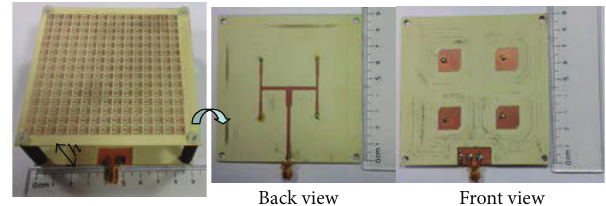
Figure 20: Prototype of FL-LHM antenna arrays with dimensions of 90 × 90 × 30 mm 3 .